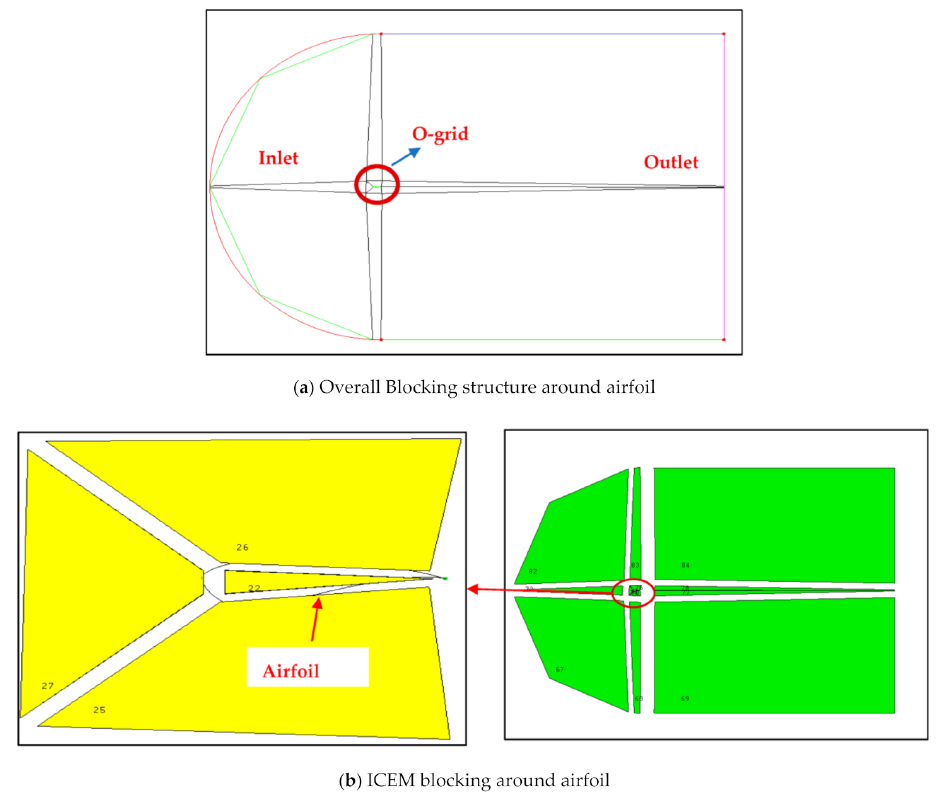
Figure 6. Blocking topology